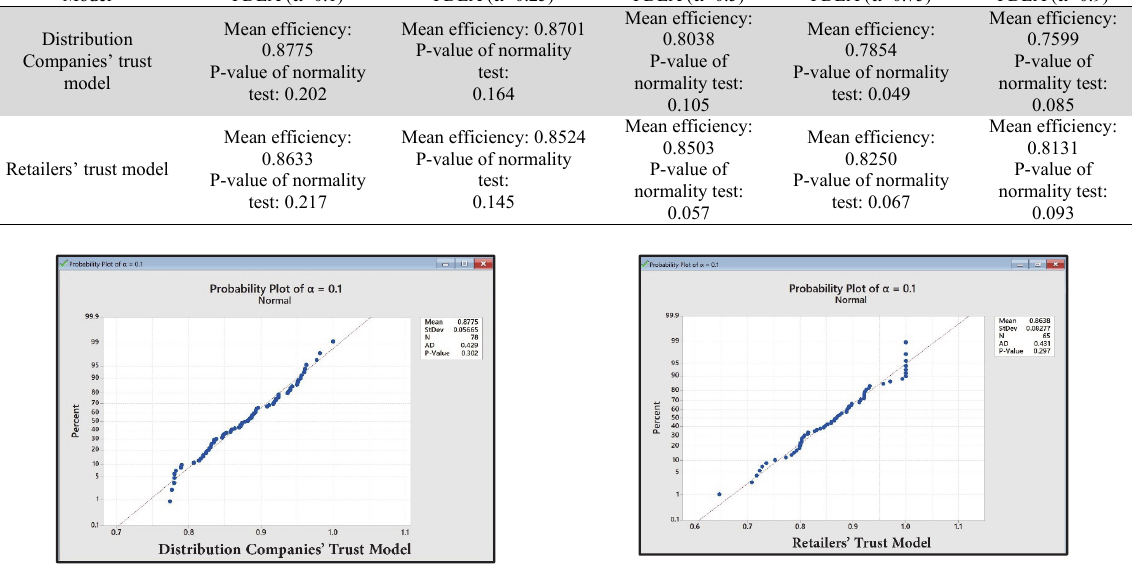
Fig. 5. The results of the normality test for selected optimum FDEA α